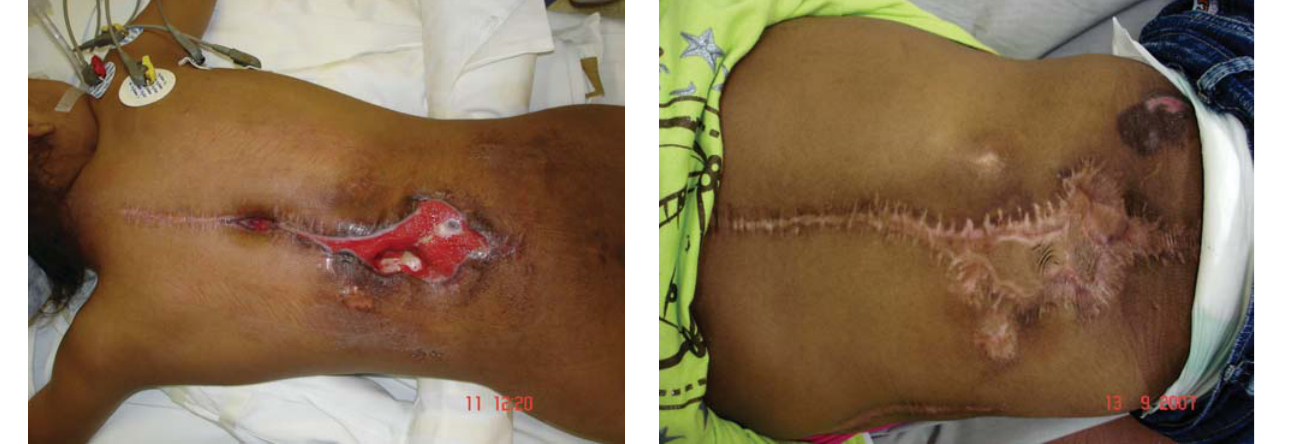
Figure 7 - After serial wound debridement and hyperbaric oxygen therapy, the infection was significantly improved, but a deep wound still persisted at the lower lumbar level, exposing the vertebral bodies and a small portion of the implant. There was also a less severe thoracic wound that did not close